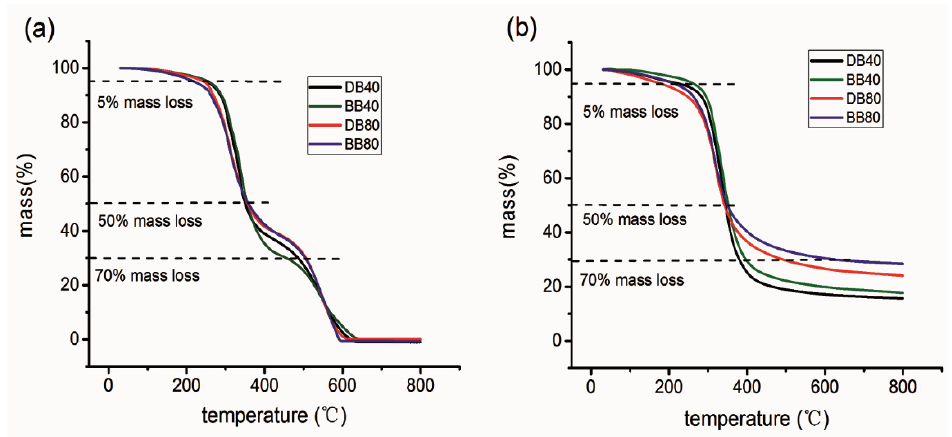
Figure 7. TG curves of the DB40, DB80, BB40, and BB80 resins under air ( a ) and N 2 ( b ) conditions.